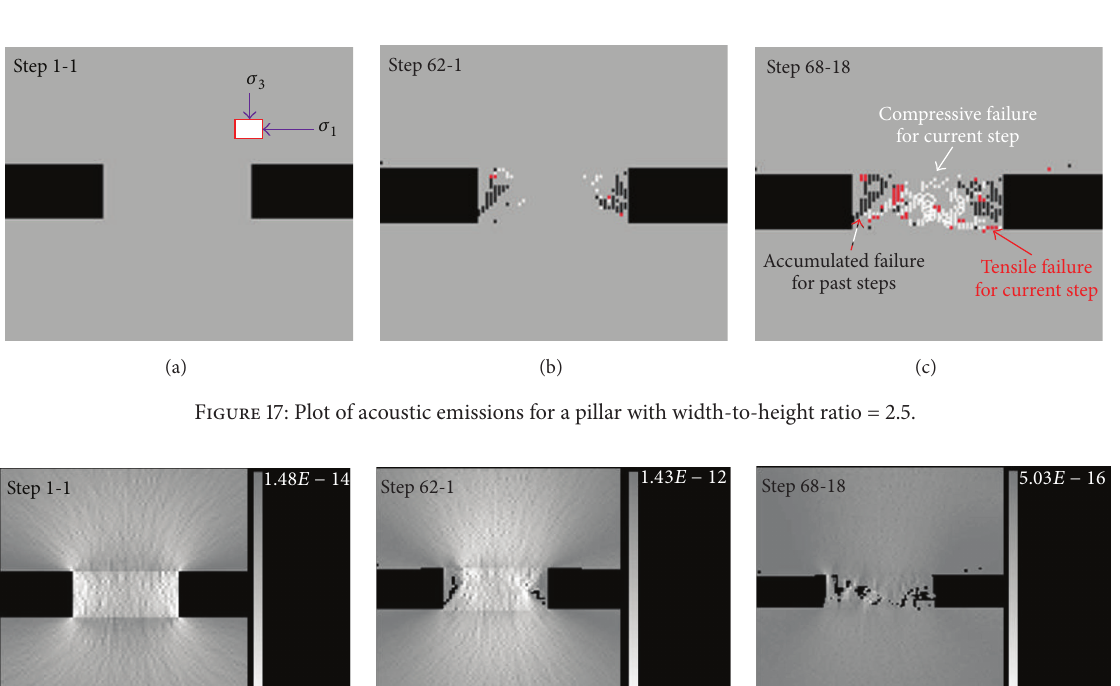
Figure 16: Average axial stress-strain curve for a pillar with width-to-height ratio = 2.0.